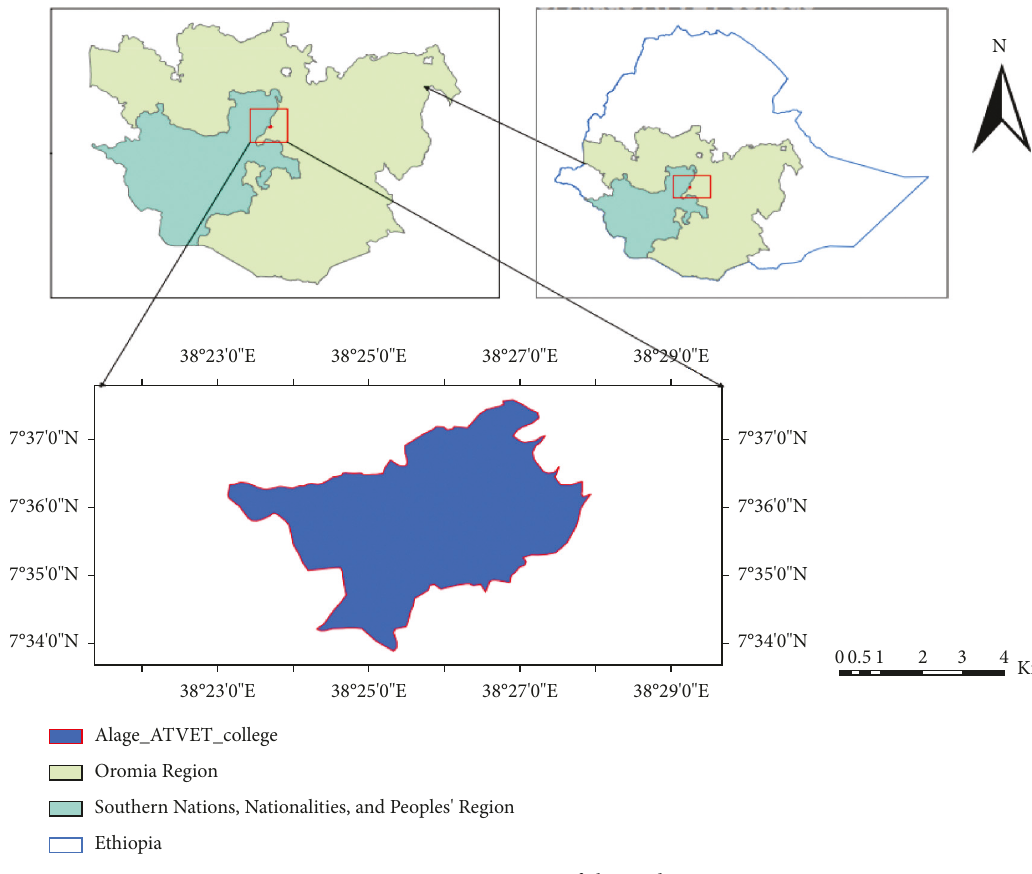
Figure 1: Location map of the study